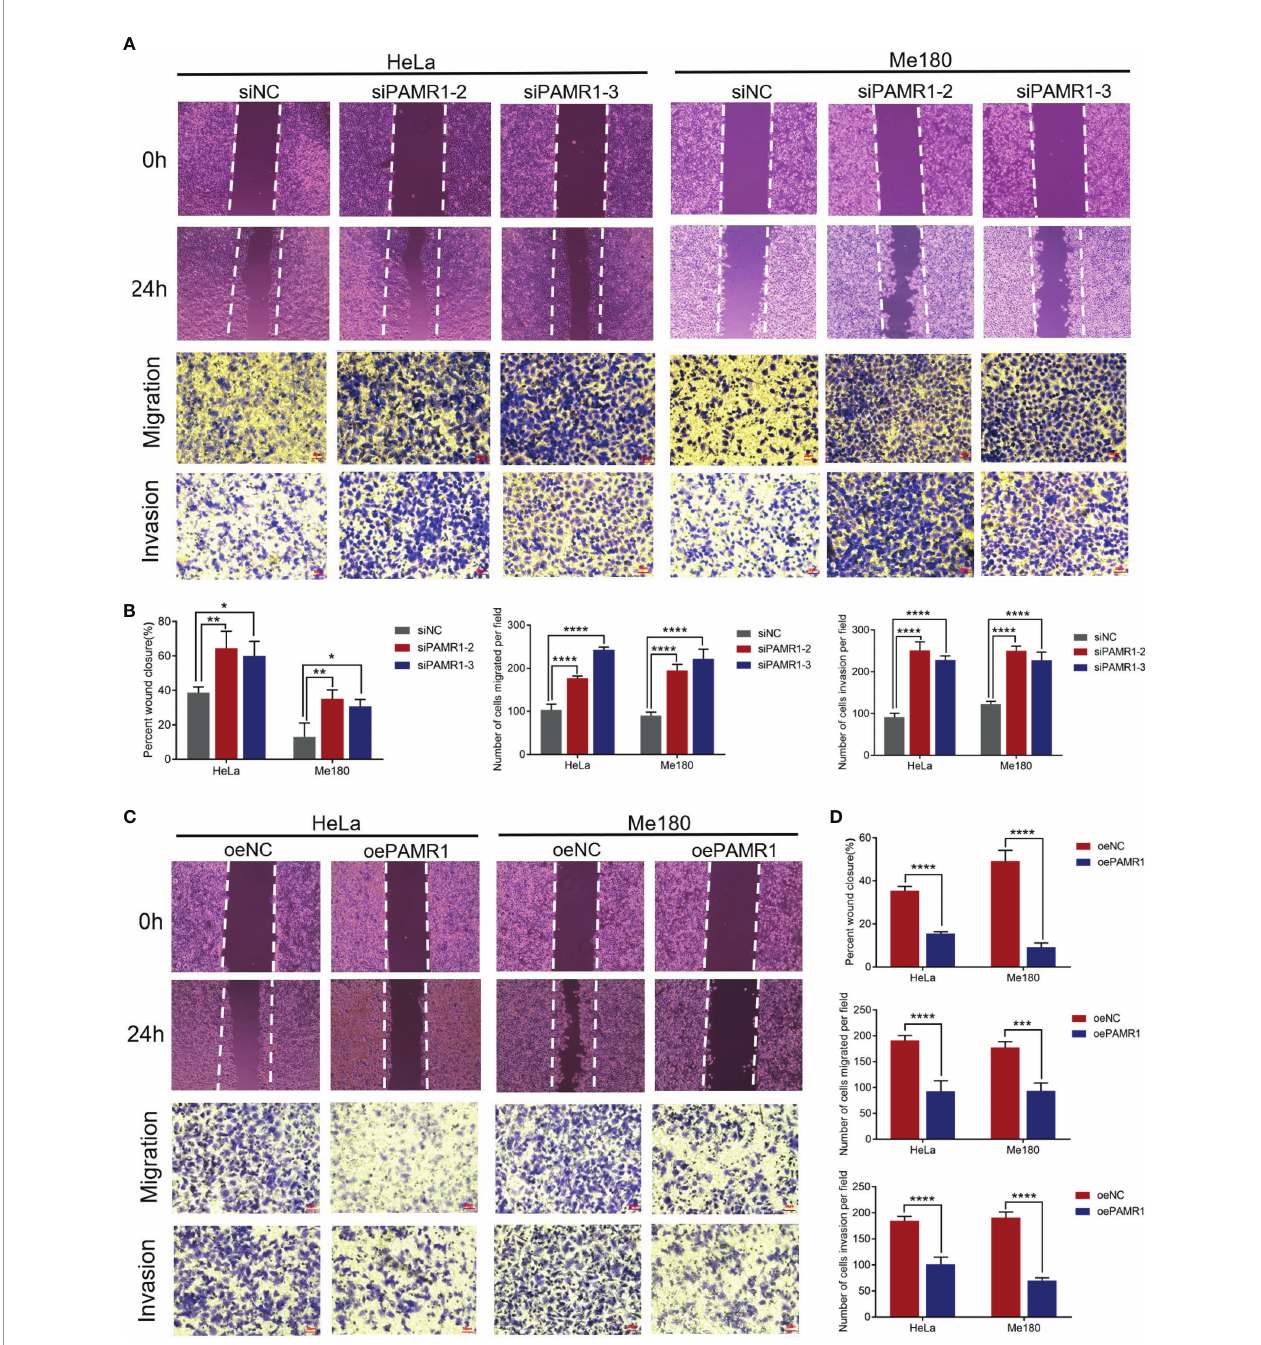
FIGURE 3 | PAMR1 inhibited the migration and invasion of cervical cancer cell lines. (A, B) Wound-healing and Transwell assays after PAMR1 knockdown by siRNA in HeLa and Me180 cells. Scale bar = 50 m m. (C, D) Wound-healing and Transwell assays after PAMR1 overexpression in HeLa and Me180 cells. Scale bar = 50 m m. * p < 0.05, ** p < 0.005, *** p < 0.0005, **** p <